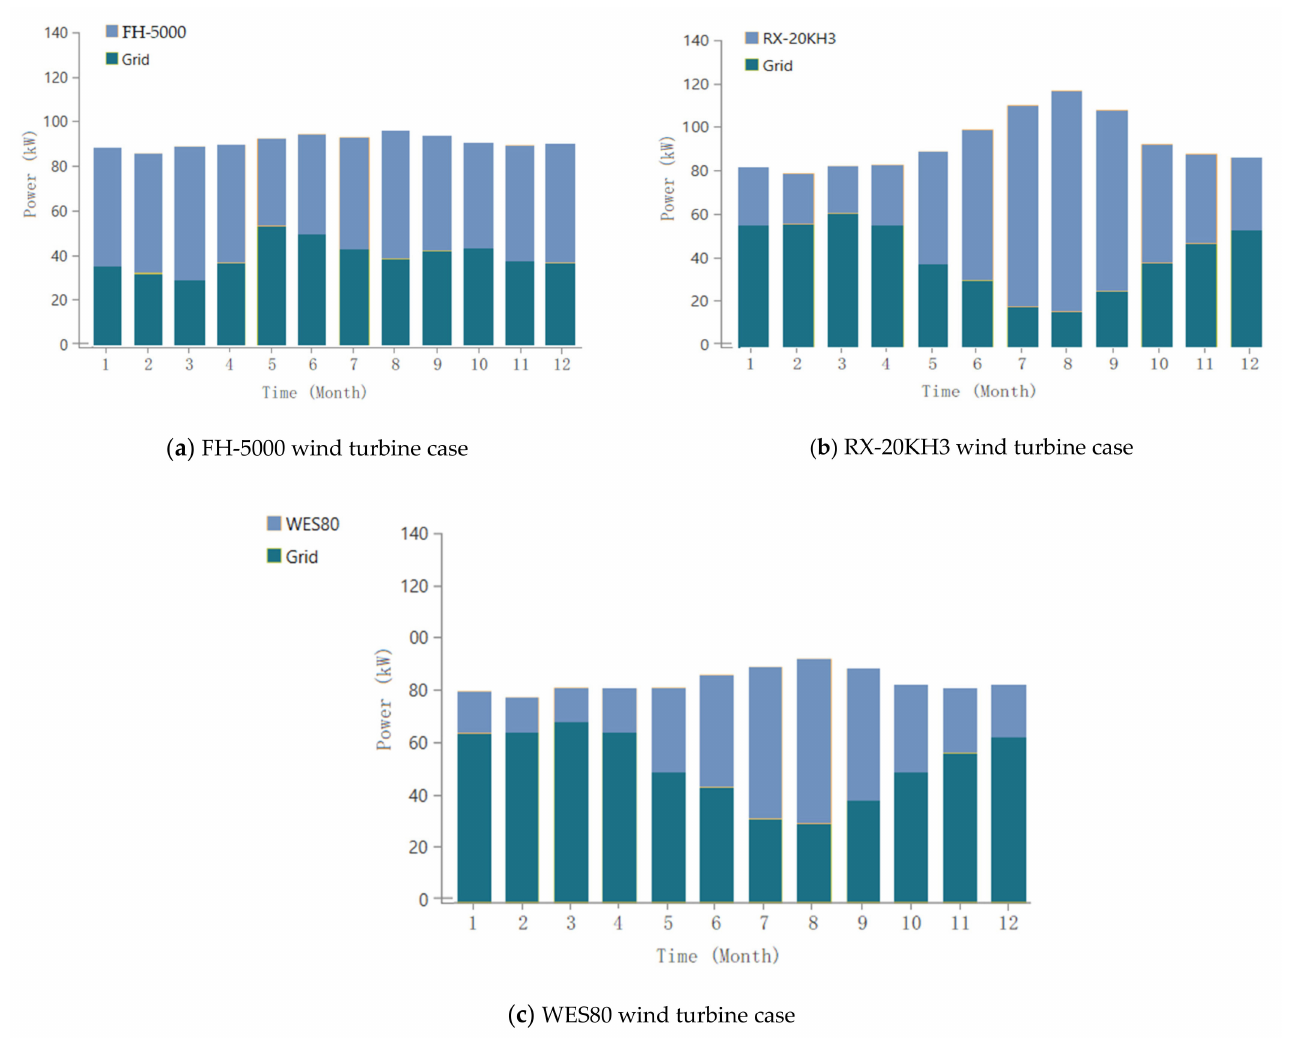
Figure 12. Monthly average of electric power generation in